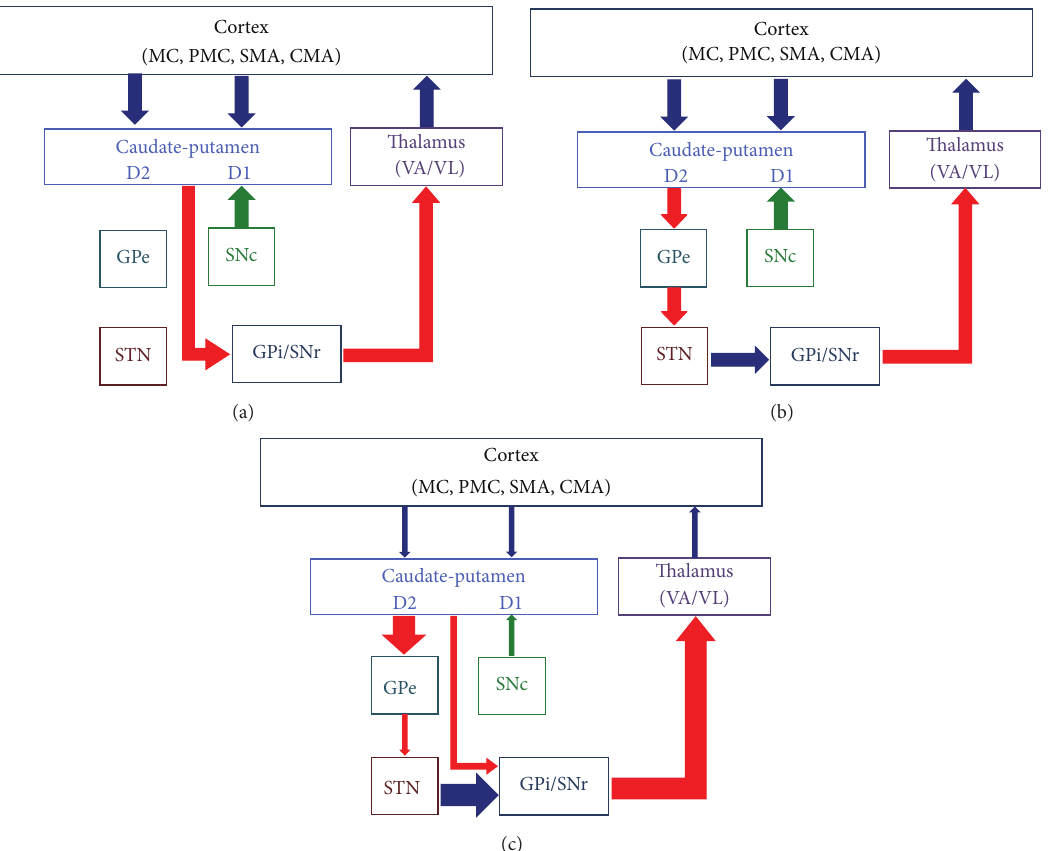
Figure 1: A simplified view of the functional anatomy of the basal ganglia (BG). The main input and output connections and the basic internal circuitry of the BG are shown. Here are represented the direct pathway (panel (a)), the indirect pathway (panel (b)), and the alteration of the balance between the direct and indirect pathways in Parkinson’s disease (panel (c)). Blue arrows show the excitatory glutamatergic pathways, red arrows indicate the inhibitory GABAergic pathways, and green arrows mark the dopaminergic pathway. CMA: cingulate motor area; D1: dopamine D1 receptor; D2: dopamine D2 receptor; GPe: external segment of the globus pallidus; GPi: internal segment of the globus pallidus; MC: primary motor cortex; PMC: premotor cortex; SMA: supplementary motor area; SNc: substantia nigra pars compacta; SNr: substantia nigra pars reticulata; STN: subthalamic nucleus; VA/VL: ventral anterior/ventrolateral thalamic